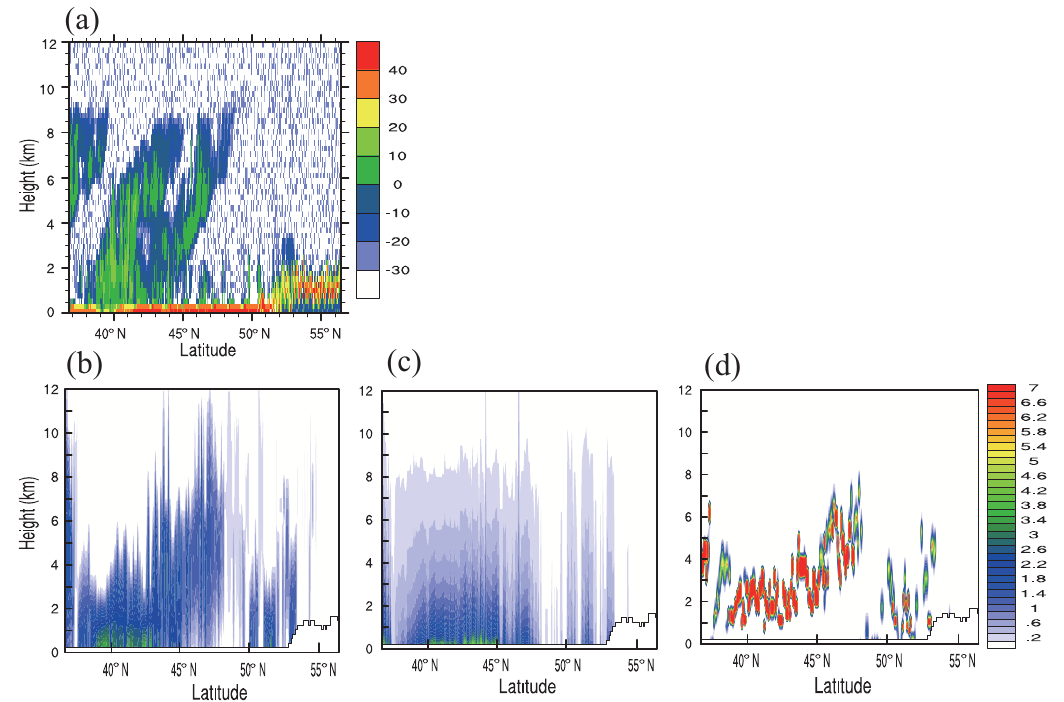
Figure 4. (a) The radar reflectivity (units: dBZ) cross sections from CloudSat, (b) the MMR retrieved cloud fraction (units: %) cross sections,